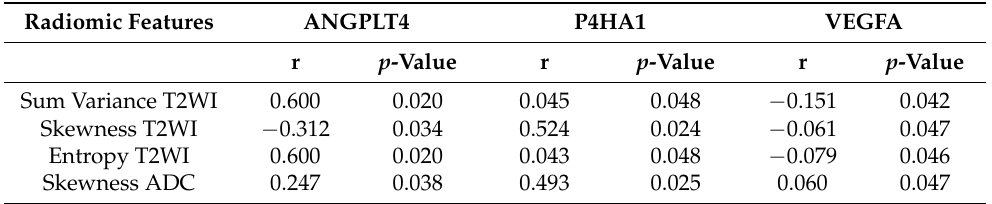
Figure 3. Correlation heatmap showing the three differentially expressed hypoxia-related genes with radiomic texture features. Table 3. Corelation between radiomic histogram and GLCM texture features with three differentially expressed hypoxia genes in prostate cancer ( p -value <